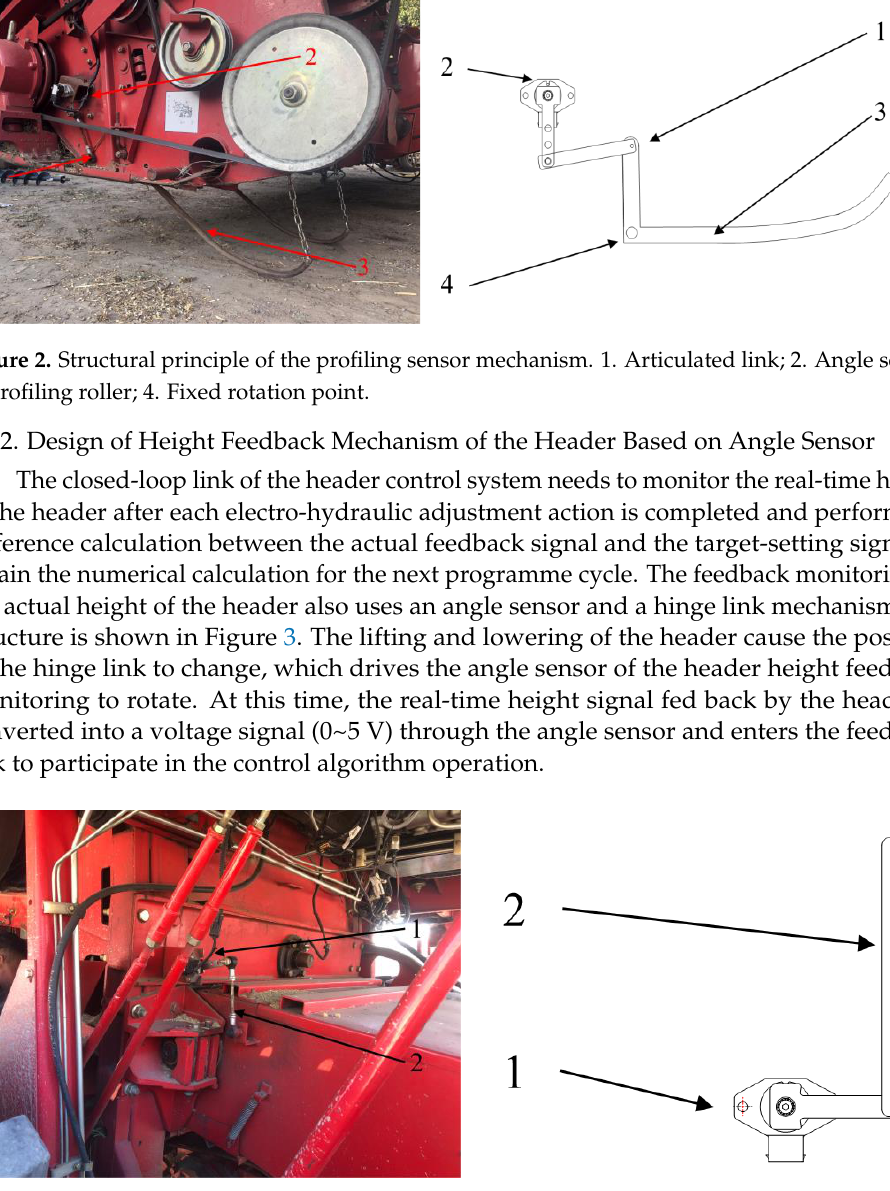
Figure 1. The structure of the ground profile height control system of the header. 1. Profiling roller; 2. Angle sensor; 3. Single-acting hydraulic cylinder; 4. Traditional harvester header structure; 5. Header lift rotation point; 6. Header height feedback mechanism.